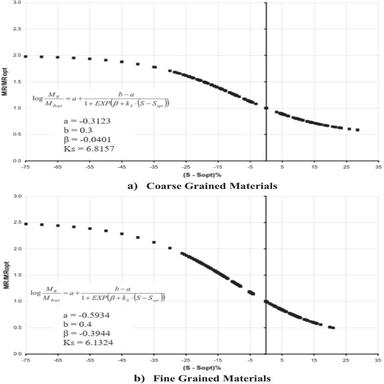
Effect of Water Content Level on MR/MROpt Ratio for a) Coarse-Grained and b) Fine-Grained Materials.